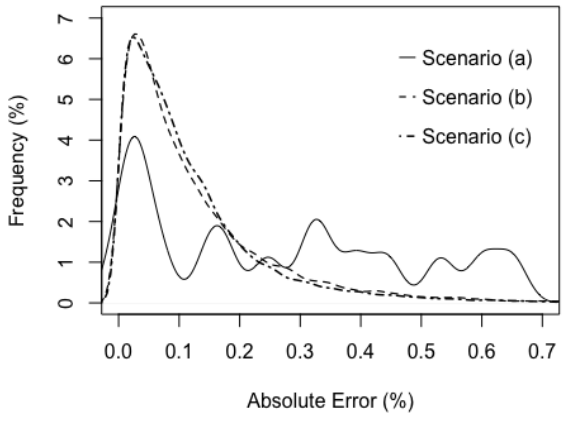
Figure 5. Case study 2: Distribution of wind power forecasting errors in scenarios ( a ) – ( c ).